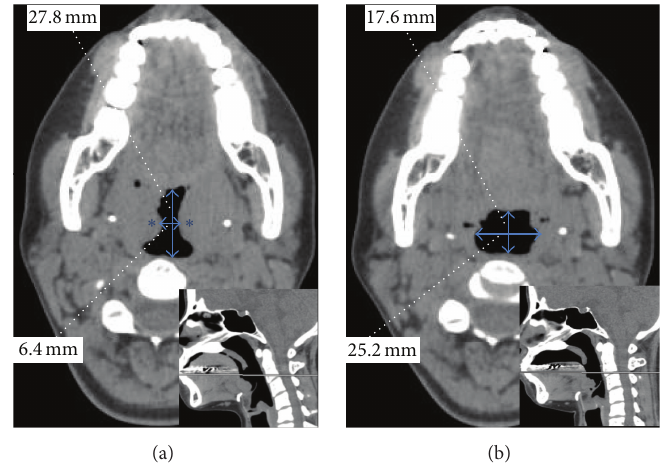
Figure 1: Axial-view computed tomography images from patient 1. (a) The narrowing of glossopharynx (blue double-headed arrows) evident before uvulopalatopharyngoplasty (UPPP) was caused by the impression of large tonsils (asterisk). (b) The narrowing was enlarged transversely; however, the glossopharynx became narrower in the anteroposterior direction after UPPP (indicated by the number). The lines on midsagittal view indicate the level of the